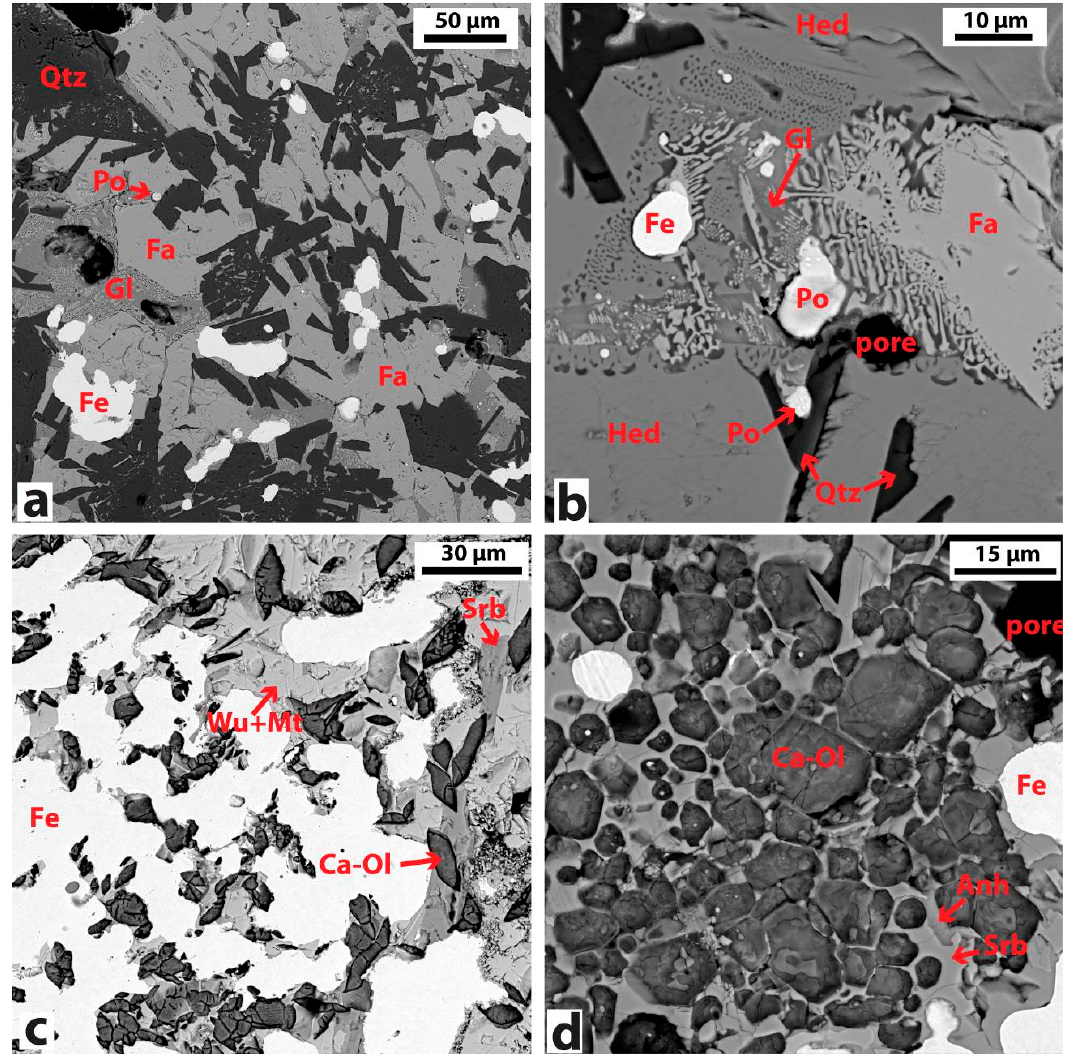
Figure 11. Typical microstructures of slag from P CB . SEM-BEI. P CB type 1 ( a , b ): ( a ) Arabah-2. Porphyritic grains of quartz (Qtz), large prismatic crystals of fayalite (Fa), prills of pyrrhotite (Po) in a microlitic glassy (Gl) matrix; ( b ) Negev-7. Tabular crystals of quarts, large crystals of hendenbergite (Hed), euhedral crystal of fayalite, which peripherally formed ex-solution texture with residual slag melt (glass); P CB type 2 ( c,d ): ( c ) Ajloun-2. Area of reduced metal (Fe) and slag. The slag is composed of rhomboid crystals of calico-olivine (Ca-Ol), elongated crystals of srebrodolskite (Srb), and magnetite-wustite ex-solution (Mt-Wu); ( d ) Negev-9. Slag composed of subhedral calico-olivine, finely resolved srebrodolskite, and localized anhydrite (Anh).